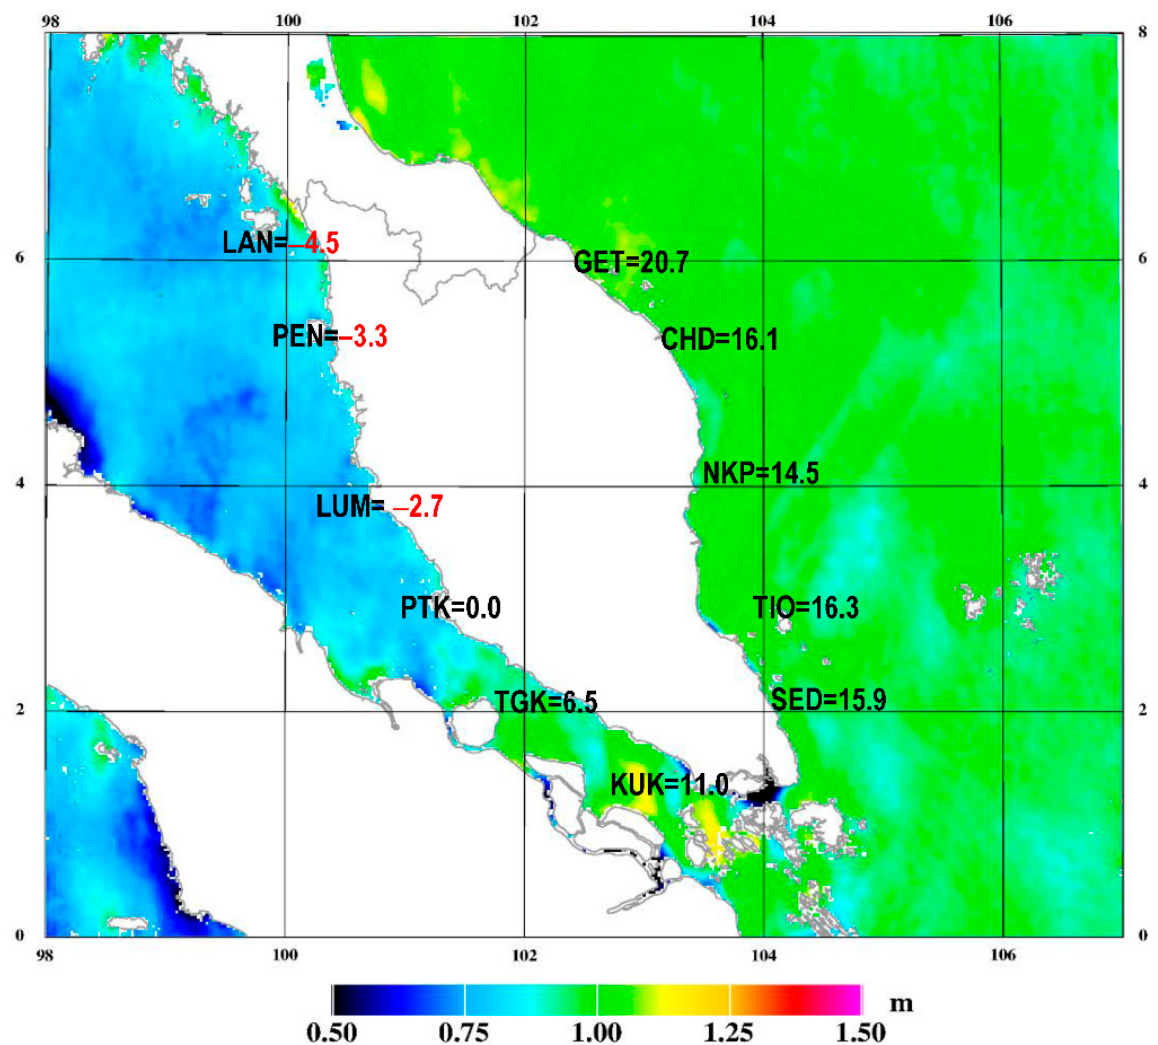
Figure 15. The magnitude of sea slopes (RMDT G ) in cm along the Malacca Strait and the South China Sea relative to Port Klang (PTK). The background map is the MDT SALT from the DTU21 altimetry dataset. The strong resemblance of sea slopes derived from TGs and DTU21 is observed.